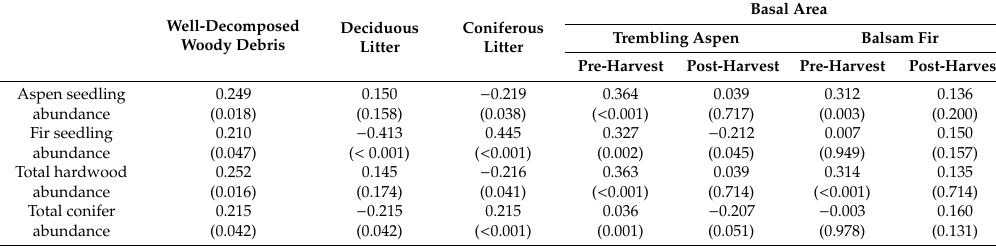
Table 5. Pearson correlation coe ffi cient ( p -values) between substrate type cover and trembling aspen and balsam fir basal area before and after harvesting, and seedling